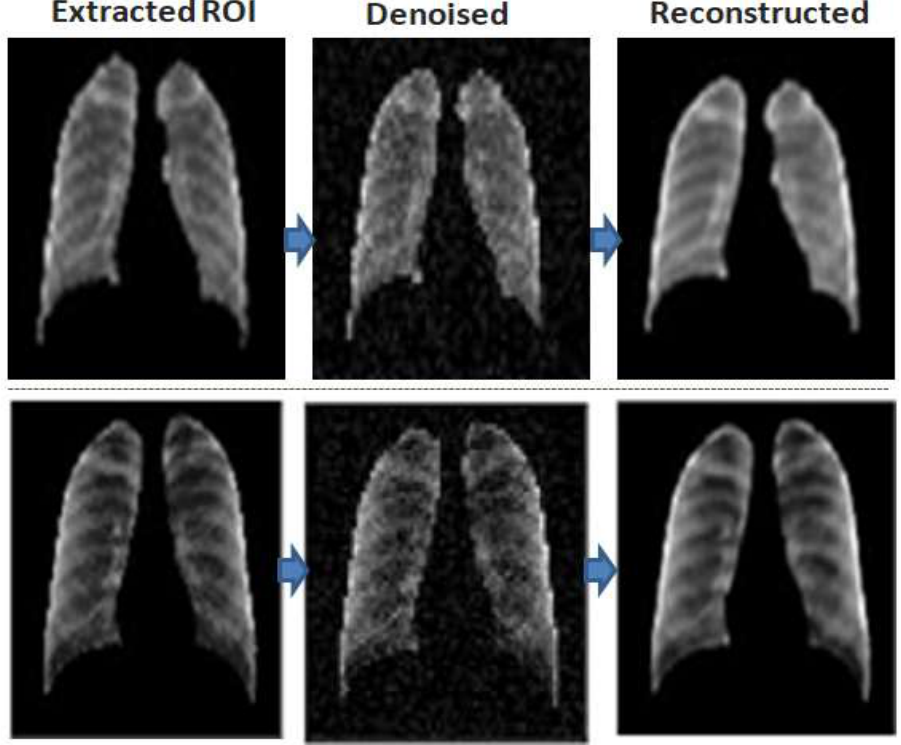
Figure 7. Visualization of two original scan samples , their corresponding denoised results from the convolutional DEA with noise factor 0.01, and their reconstructed mapped image.